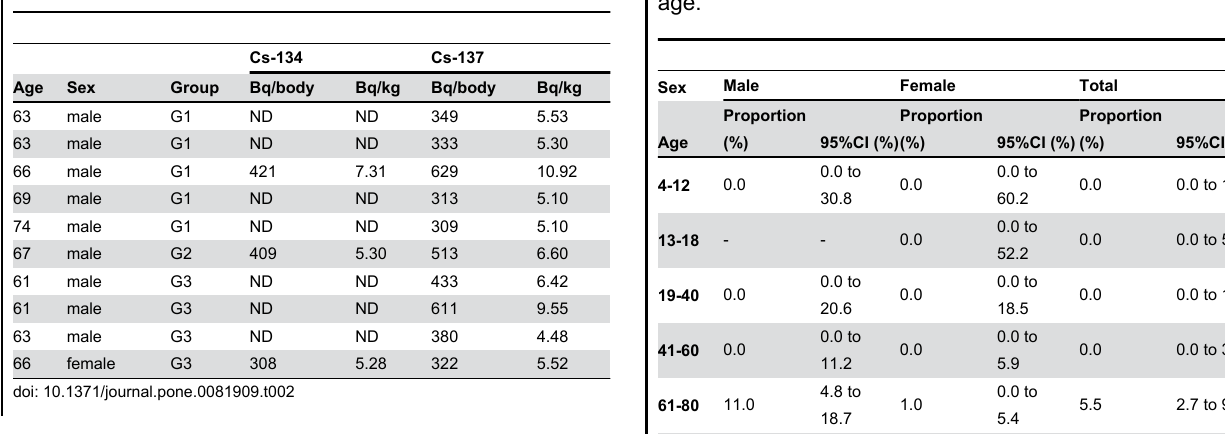
Table 2. List of subjects with traceable levels of Cs in Kawauchi village.